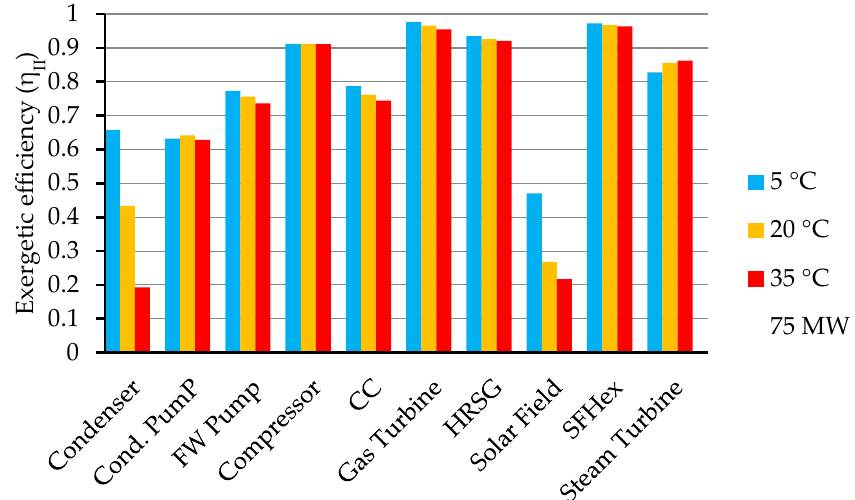
Figure 8. Exergetic efficiency of different components of the ISCC at different ambient temperatures for solar heat input equal to 75 MW.